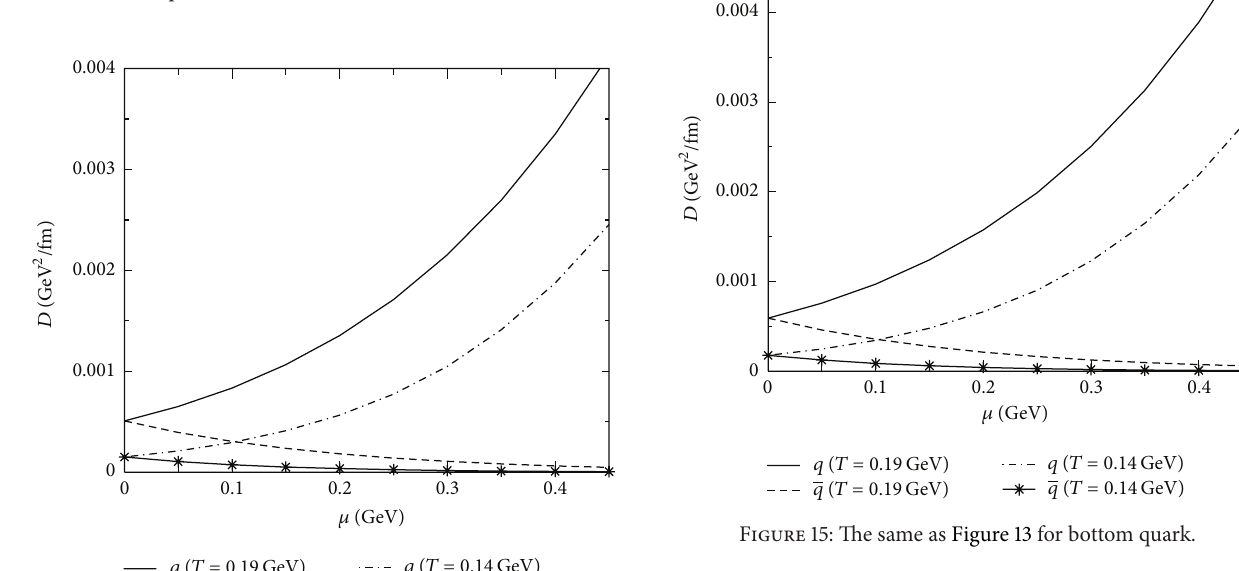
Figure 12: Variation of the drag coefficient of charm quark due to its interactions with light quarks and anti-quarks as a function of 𝜇 for different temperatures.